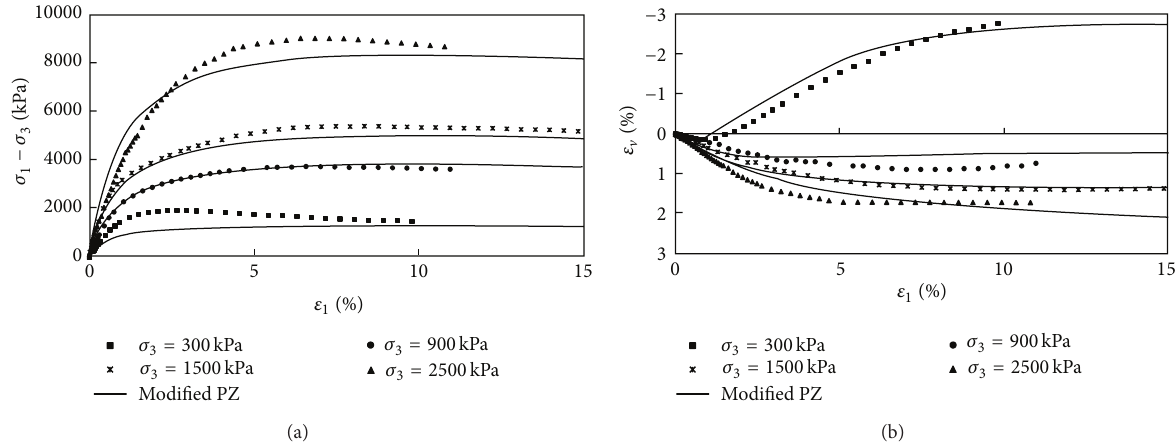
Figure 7: Comparison between fittings of the modified PZ-III model and experimental triaxial tests results for rockfill material